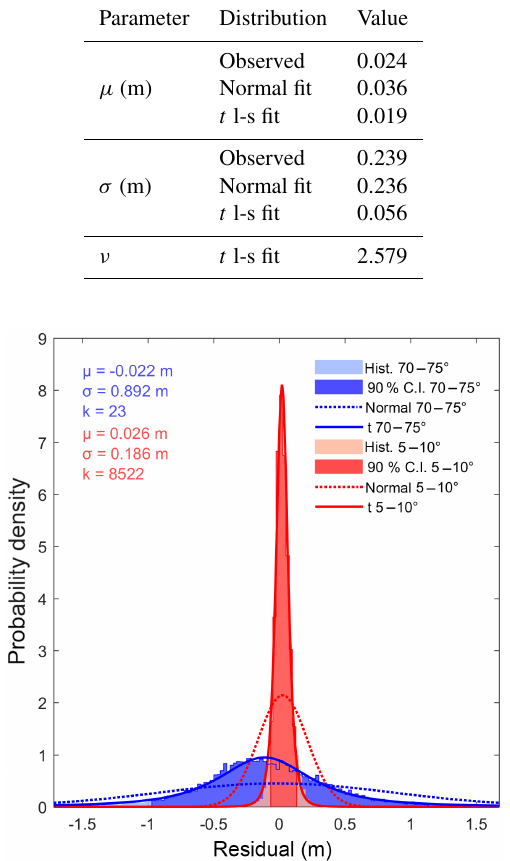
Table 5. Observed (calculated under Gaussian assumption) and fit- ted normal and t location-scale ( t l-s) parameters for the residual distributions shown in Fig. 5b.